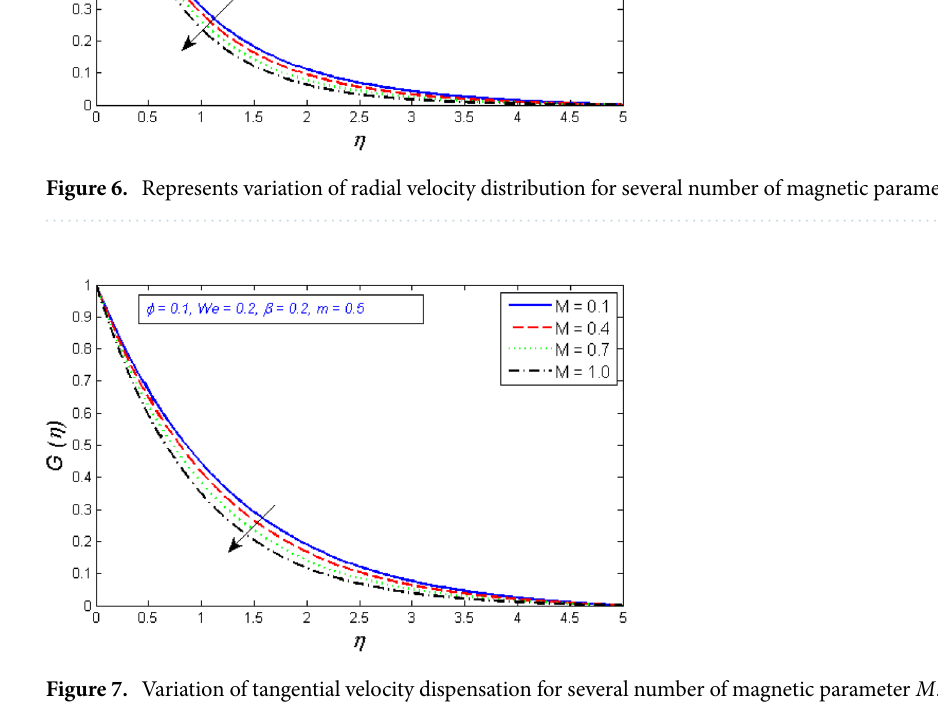
Figure 7. Variation of tangential velocity dispensation for several number of magnetic parameter M